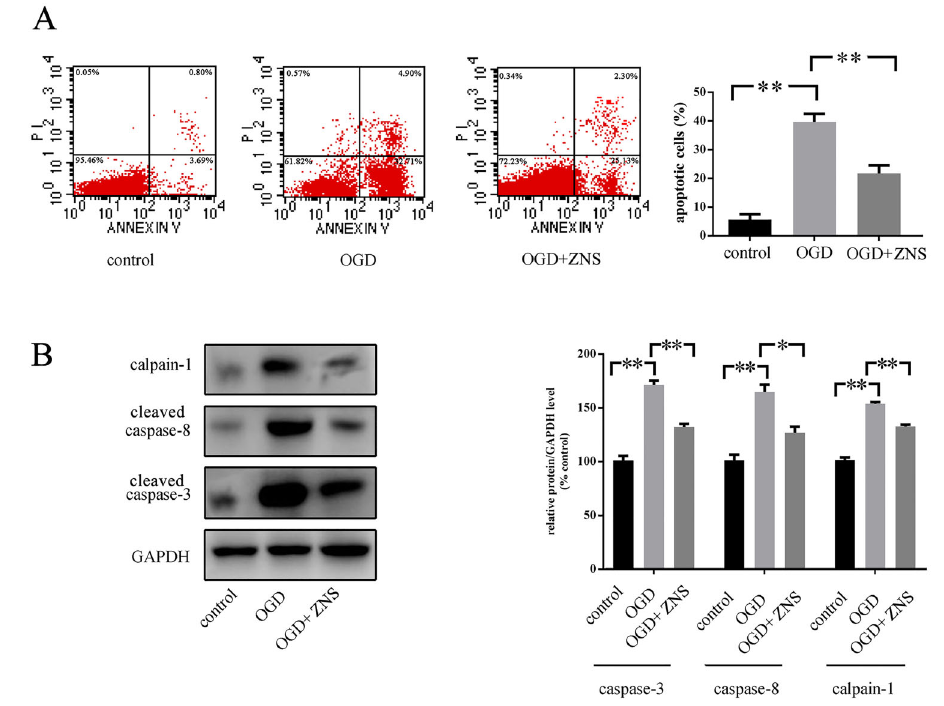
Figure 1. HT22 cells were pretreated or not with zonisamide (ZNS), and then exposed to oxygen glucose deprivation (OGD) conditions for 2 h. A , The number of apoptotic (annexin V-positive) cells is indicated as the percentage of gated cells. Representative images and relative quanti fi cations are shown. B , Apoptosis-related protein expression in cells under OGD. All the experiments were performed in triplicate, and the data are reported as means ± SE (*P o 0.05, **P o 0.01 one-way